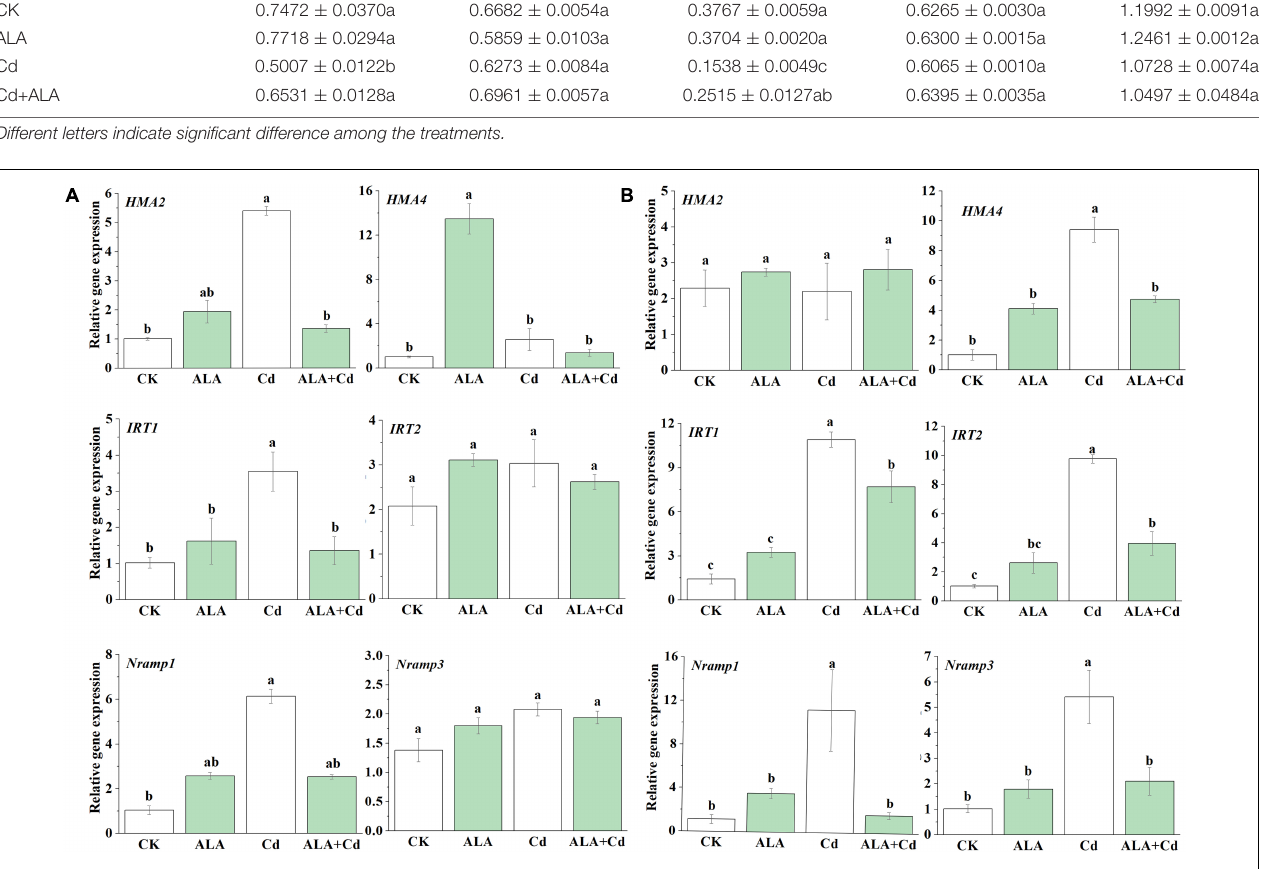
FIGURE 9 | The qRT-PCR analysis of the expression of genes involved in ion absorption and transport in Chinese cabbage seedlings in leaves (A) and roots (B) . The relative expression levels of genes are normalized to Actin . The seedlings were treated as in Figure 1 . The mean ± SE are shown ( n ≥ 3). Different letters indicate significant difference among the treatments ( P <